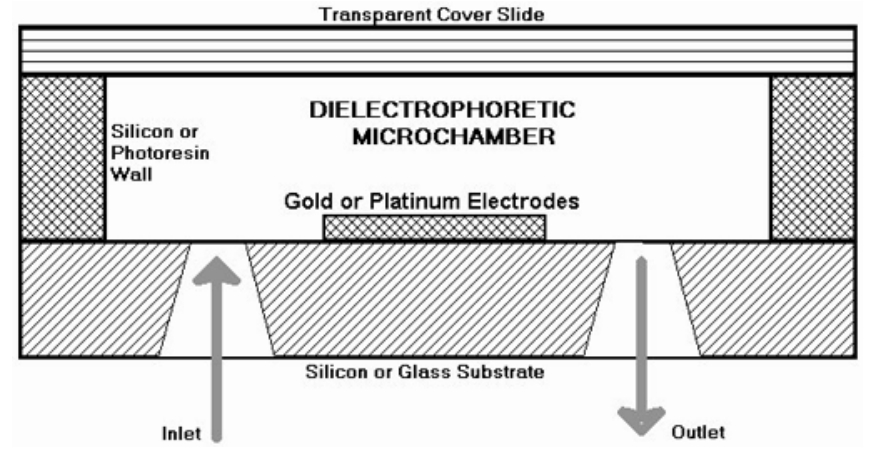
Fig. 5 – Cross-section view of the proposed microdevice. Three main components may be identified: the substrate where electrodes are grown, the electrodes itself responsible for the electric field profiles, and the silicon or photoresin walls limiting the microchamber working area. A couple of holes are drilled to bring the suspending medium onto the electrode surface. A cover slide is placed on the top of the structure to close the cavity.